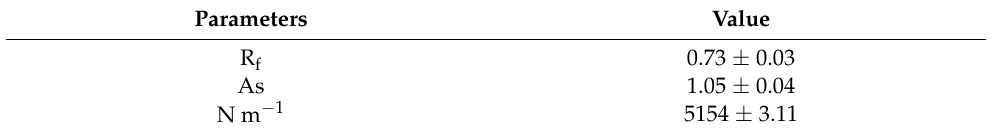
Table 2. System suitability parameters, including retardation factor (R f ), asymmetry factor (As), and number of theoretical plates per meter (N m − 1 ) of HSP for a sustainable RP-HPTLC method (mean ± SD; n = 3).